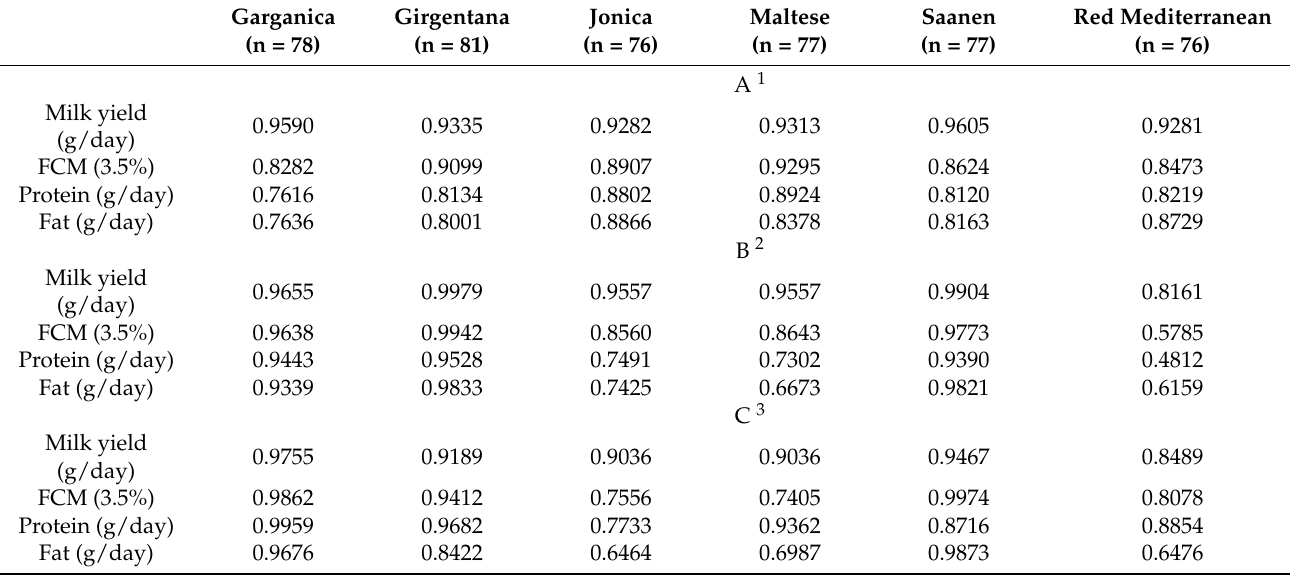
Table 2. Estimated Wood’s model R 2 values for milk yield (g/day) and FCM (fat-corrected milk) to 3.5% of fat, protein, and fat (g/day) in six breeds of